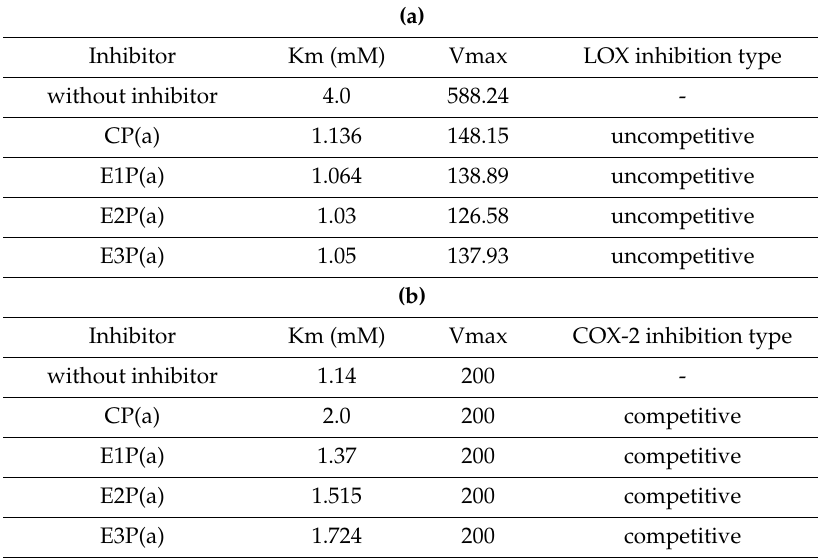
Symbols: CP(a)—purified anthocyanin fraction from pomace obtained from raspberry control pulp. E1P(a)—purified anthocyanin fraction from pomace obtained from raspberry pulp macerated with Pectinex Ultra SP-L; E2P(a)—purified anthocyanin fraction from pomace obtained from raspberry